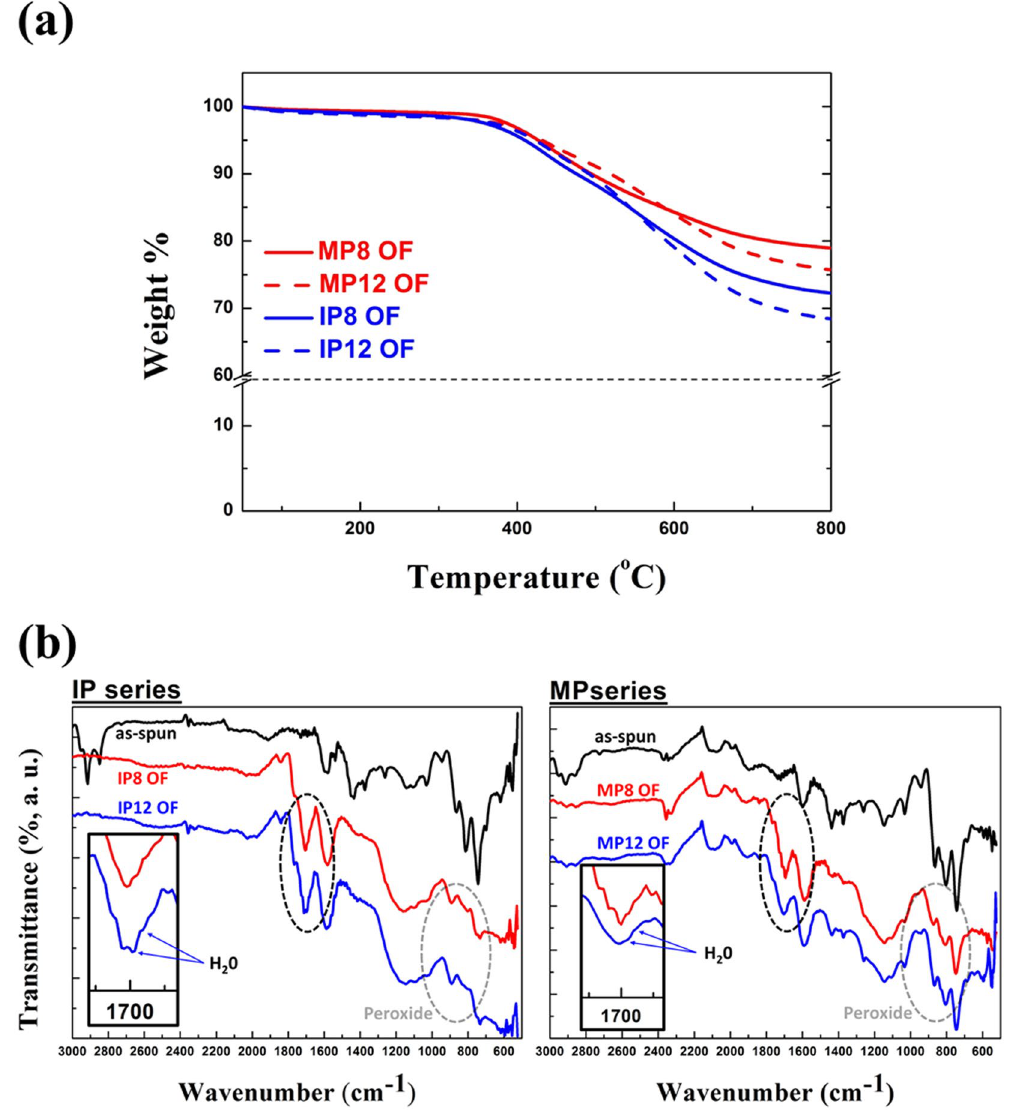
Figure 8. ( a ) TGA curves of different OFs under N 2 gas to compare the weight remaining after oxidation durations of 8 h and 12 h and ( b ) FT-IR spectra of IP and MP